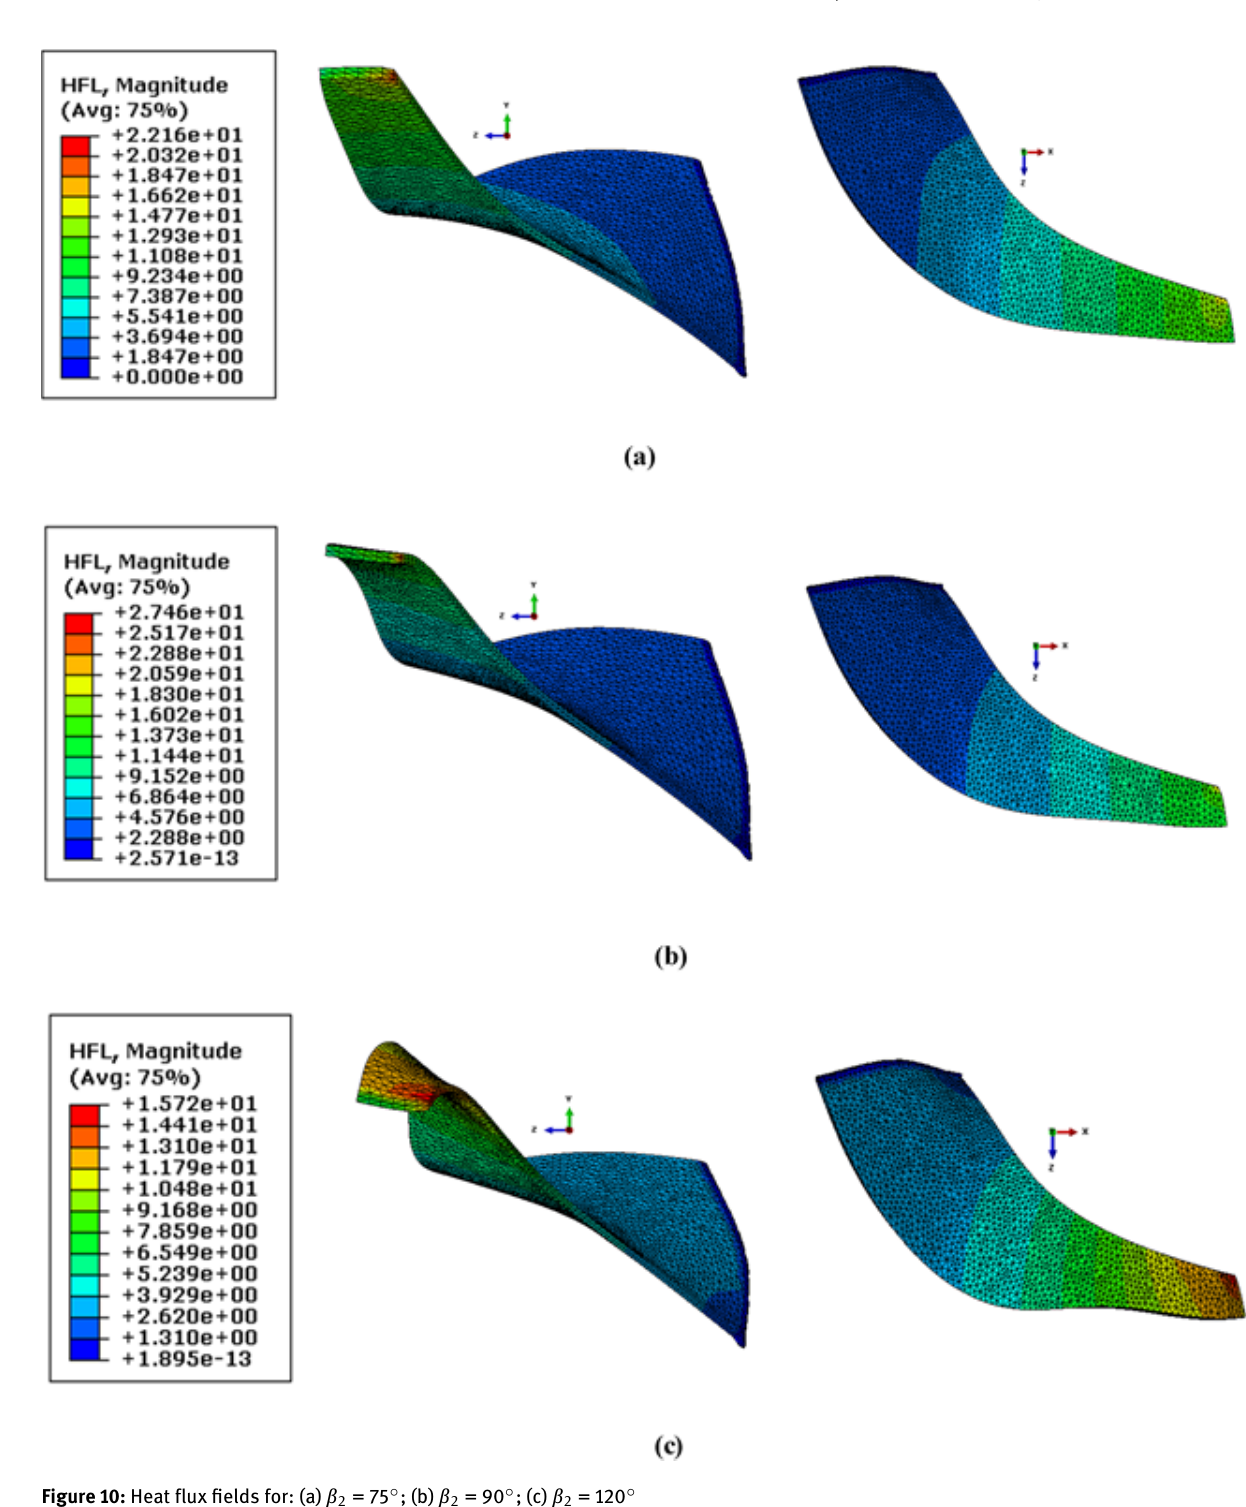
(Figure 10). The highest heat flux values are found in the blade in the case of forward lying blade β case of the radial blade β = 90 ∘ . The maximum heat flux lower value compared to other cases. Temperature varia- 2 is concentrated at the outlet of the blade (trailing edge). It tions can lead to thermal expansion. They can have an in- is spread over one more area of the upper surface of the fluence on the behavior insofar as the characteristics of